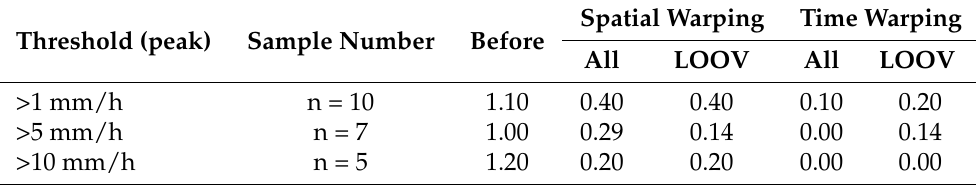
Table 6. Average absolute timing error before and after spatial warping. The average is over all stations recording at least one time step with more rainfall than a certain